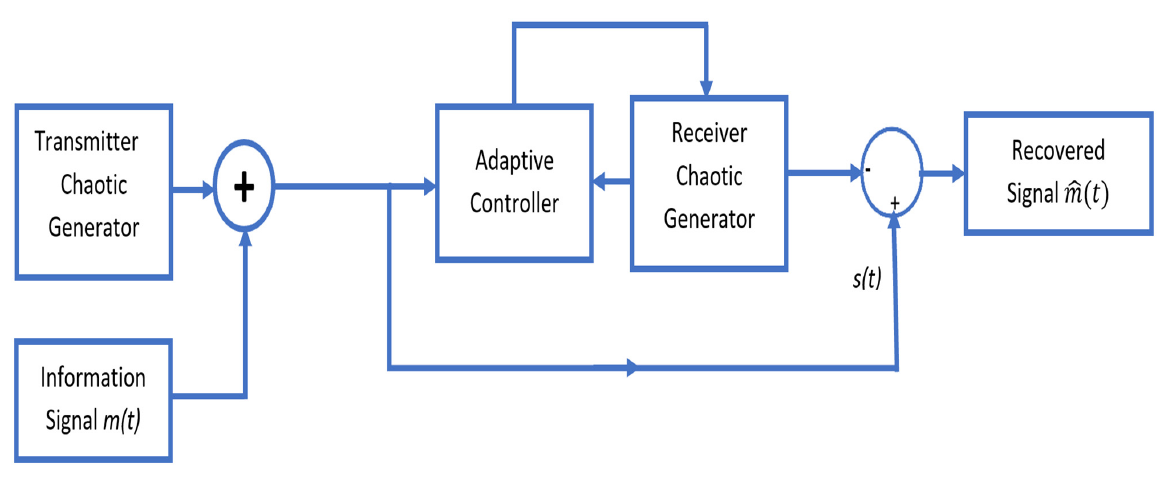
Figure 8. Block diagram of secure-communication-system-based chaotic masking.